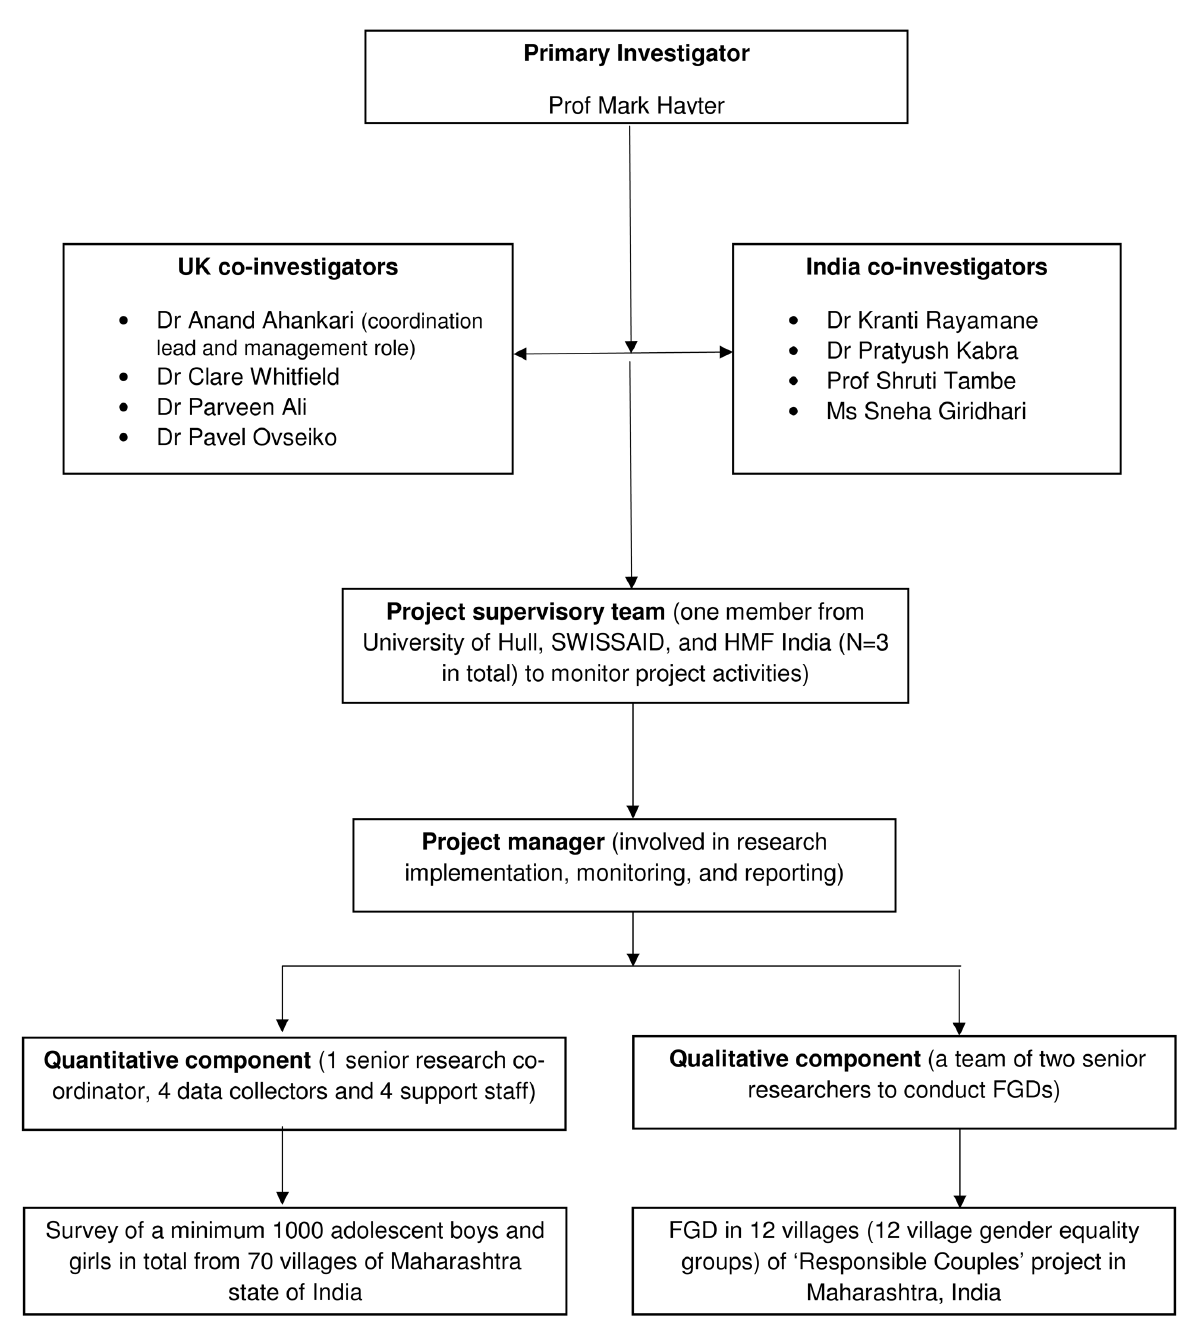
Figure 1. DEVELOP project structure. HMF, Halo Medical Foundation; FGD, focus group